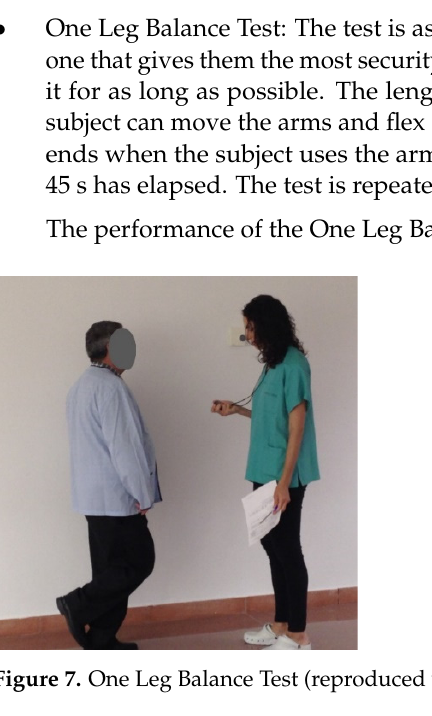
Figure 6. STS-5 Test (reproduced with permission from Erika Meléndez-Oliva 2020) [43].